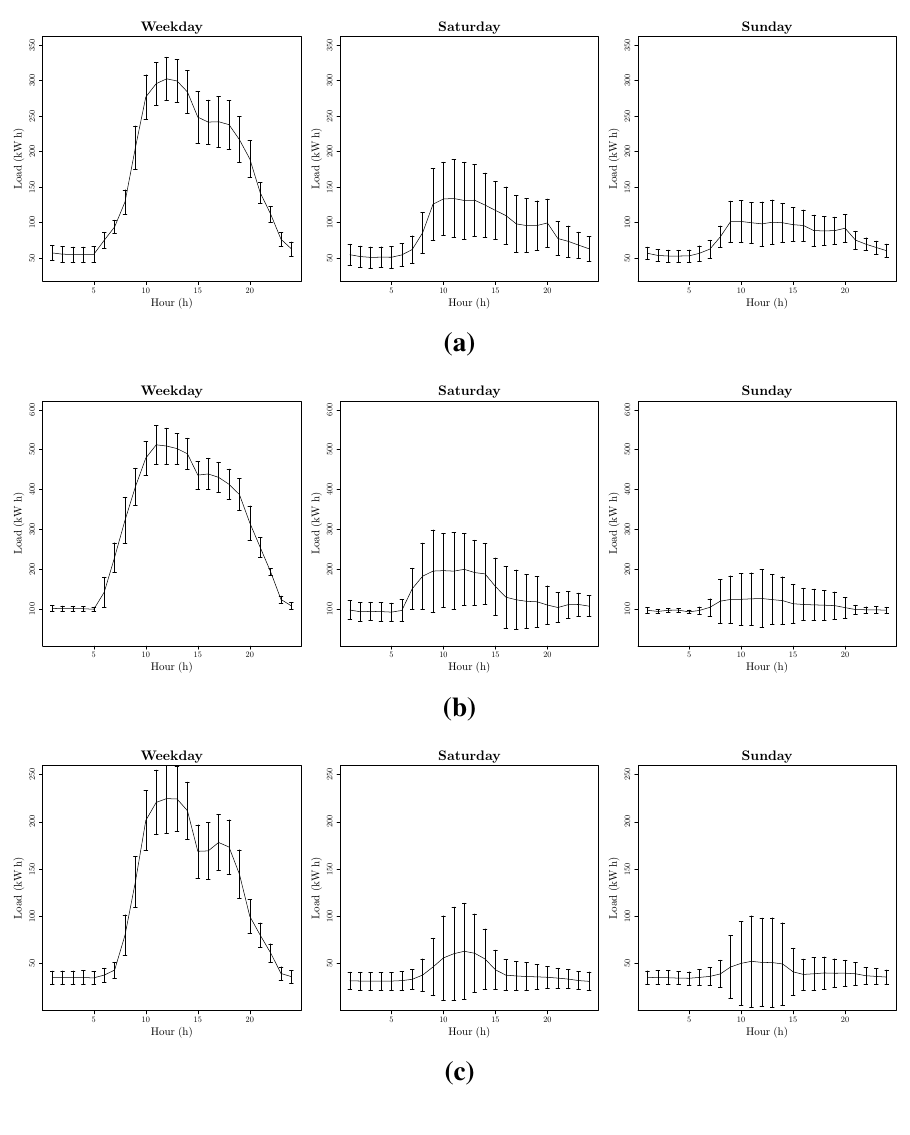
; ( b ) Dataset bilbao ; ( c ) Dataset bilbao . 1 3 4